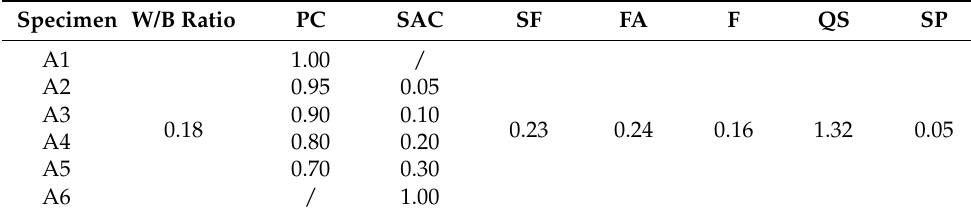
Table 2. Mix proportions of UHPC.